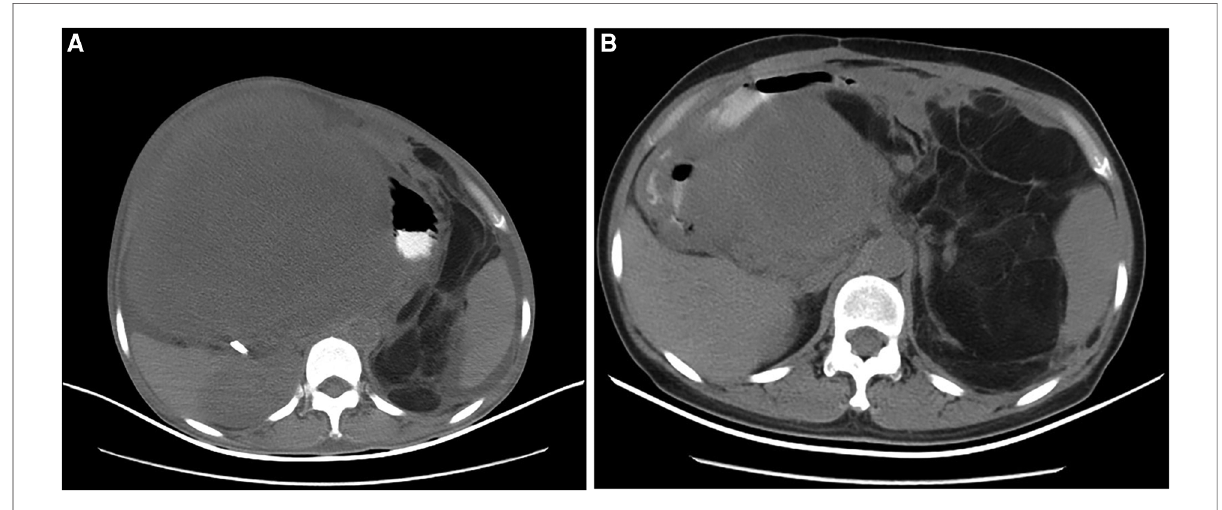
FIGURE 1 The imaging of CT scanning indicated for the second and third recurrence of the female patient in July 2010 and November 2011, respectively. ( A ) The giant tumors with adipose density occupied almost the entire abdominal cavity (July 2010); ( B ) The tumors originated from the hepatic hilar region and oppressed adjacent organs and tissues (November